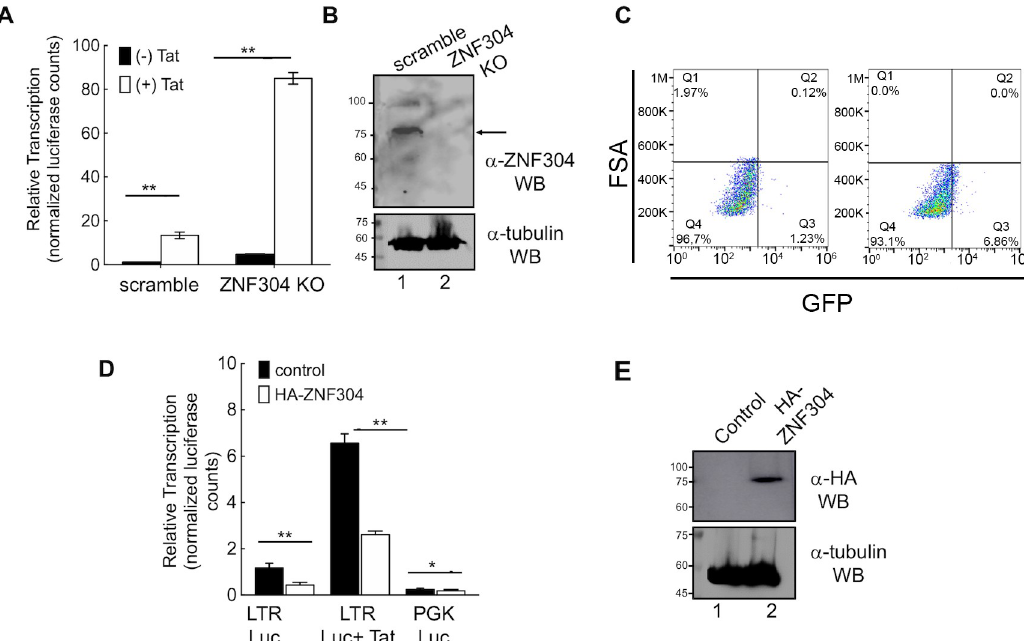
Fig 4. ZNF304 silences HIV gene transcription and modulates viral latency. A. ZNF304 affects HIV gene transcription –Jurkat cells in which ZNF304 expression was depleted (ZNF304 KO) or control cells that express scramble sgRNA were transduced with HIV-luciferase (LTR-Luc; black bars). For expressing HIV Tat, cells were further transduced with an HIV-Tat-expressing lentivirus (HIV-Luc+Tat; white bars). Luciferase activity was monitored in control and ZNF304 KO cells forty-eight hours post transduction according to the manufacturer’s protocol. Data are presented relative to luciferase readings (normalized to protein levels) in control cells that express scramble sgRNA set to 1. Bar graphs show mean values ± SD of three independent experiments. Asterisks indicate different levels of statistical significance as calculated by a two-tailed Student’s t test ( �� p � 0.01). B . Western blot analysis for depletion of ZNF304 –Lane 1, control cells expressing scramble sgRNA; Lane 2, ZNF304 KO cells. Protein levels were monitored using ZNF304 IgG. The lower gel represents tubulin western blot, confirming equal protein loading. C. Involvement of ZNF304 in promoting HIV latency – 2D10 T cells were depleted of ZNF304 expression by transducing them with a lentivirus driving the expression of a specific sgRNA that targets ZNF304 and Cas9. GFP expression was monitored by FACS. Data is presented as dot blot showing GFP expression in control and ZNF304 KO cells. D. Overexpression of ZNF304 silences HIV gene transcription – Control (black bars) or Jurkat cells that stably express HA-ZNF304 (white bars) were transduced with a lentivirus that drives the expression of HIV-LTR-Luc HIV, HIV-LTR-Tat-Luc or PGK Luc. Luciferase readings were determined according to the manufacturer’s protocol and normalized to protein concentrations determined by the Bradford method. Western blot analysis confirmed HA-ZNF304 expression using HA IgG. Asterisks indicate different levels of statistical significance as calculated by a two- tailed Student’s t test ( ��� p � 0.001; � p � 0.1). E . Western blot analysis confirming HA-ZNF304 expression—Lane 1 control cells; Lane 2 cells expressing HA-ZNF304. Western blot was performed with anti-HA IgG. The lower gel represents tubulin expression levels, confirming equal protein